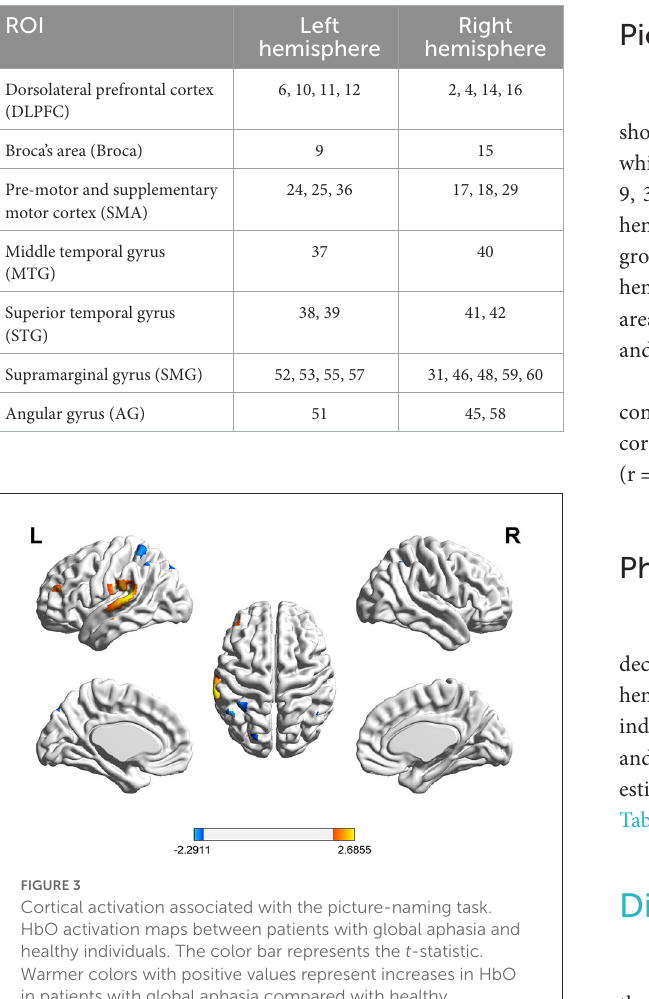
TABLE 2 Channels assigned to regions of interest.